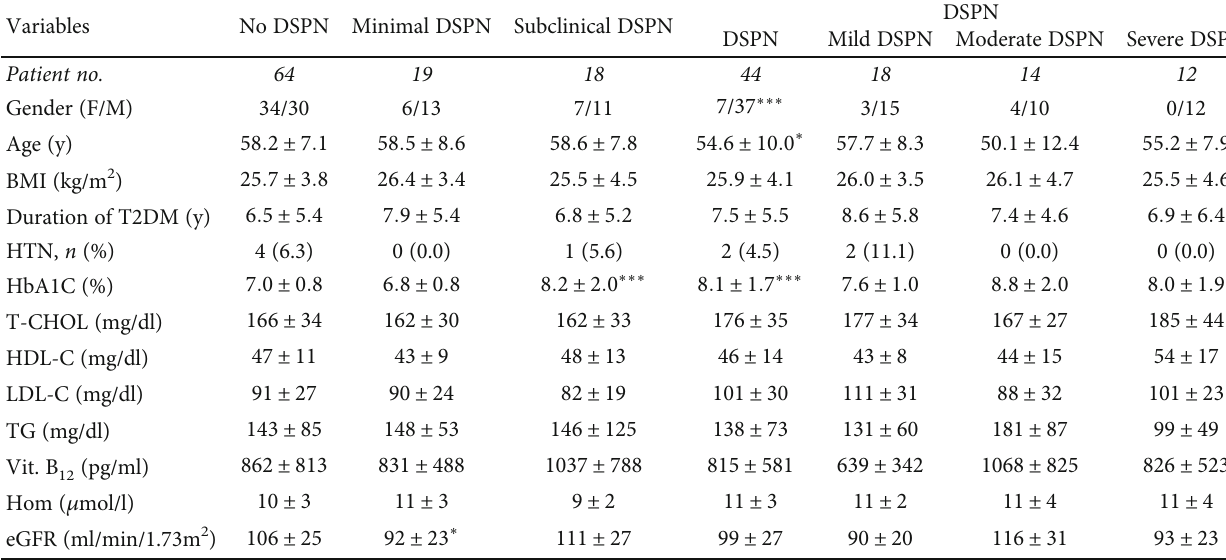
Table 2: Demographics and clinical characteristics by DSPN stage a .